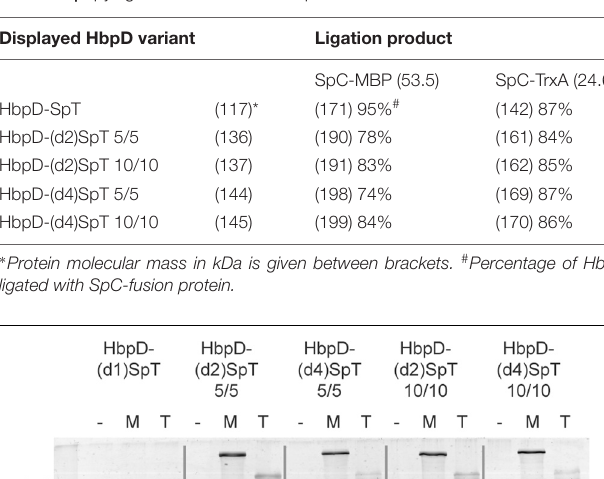
TABLE 2 | Spy-ligation efficiencies to HbpD on OMVs.